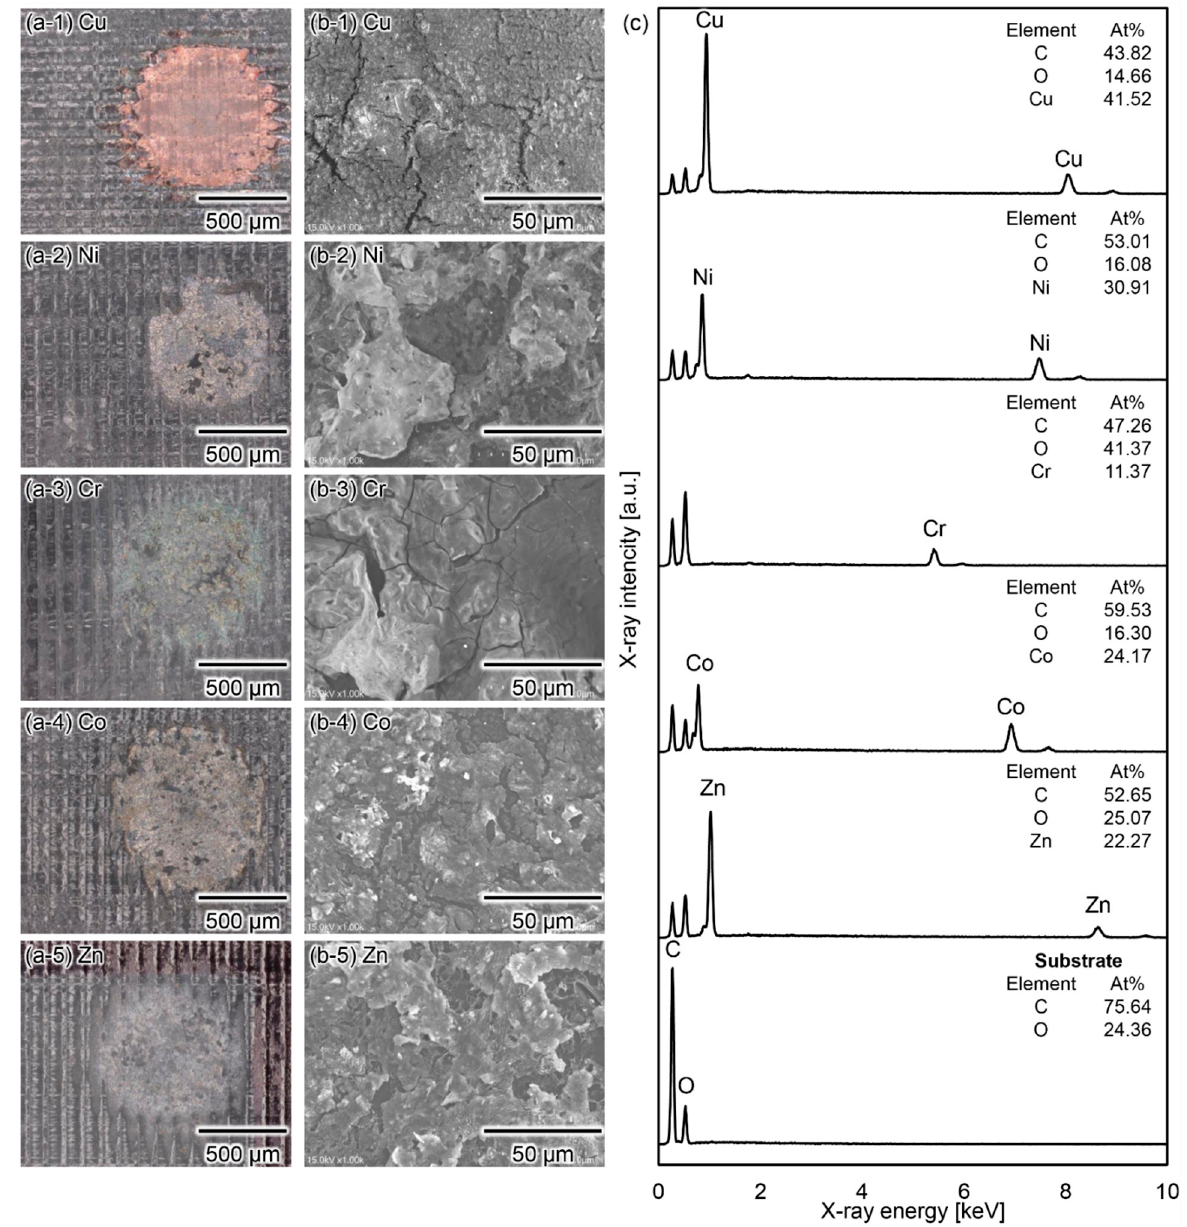
Figure 7. Deposition results of various metal species using micro-plasma bubbles. ( a ) Optical microscope image and ( b ) electron microscope image of deposition results (1-copper (Cu), 2-nickel (Ni), 3-chromium (Cr), 4-cobalt (Co), 5-zinc (Zn)) on epoxy resin. The solutions are aqueous acetate solutions, and the devices are Type B. ( c ) Elemental analysis of the deposit in ( b ) and substrate using energy dispersive X-ray spectroscopy. In all experiments, the power supply conditions were set to APSB mode.